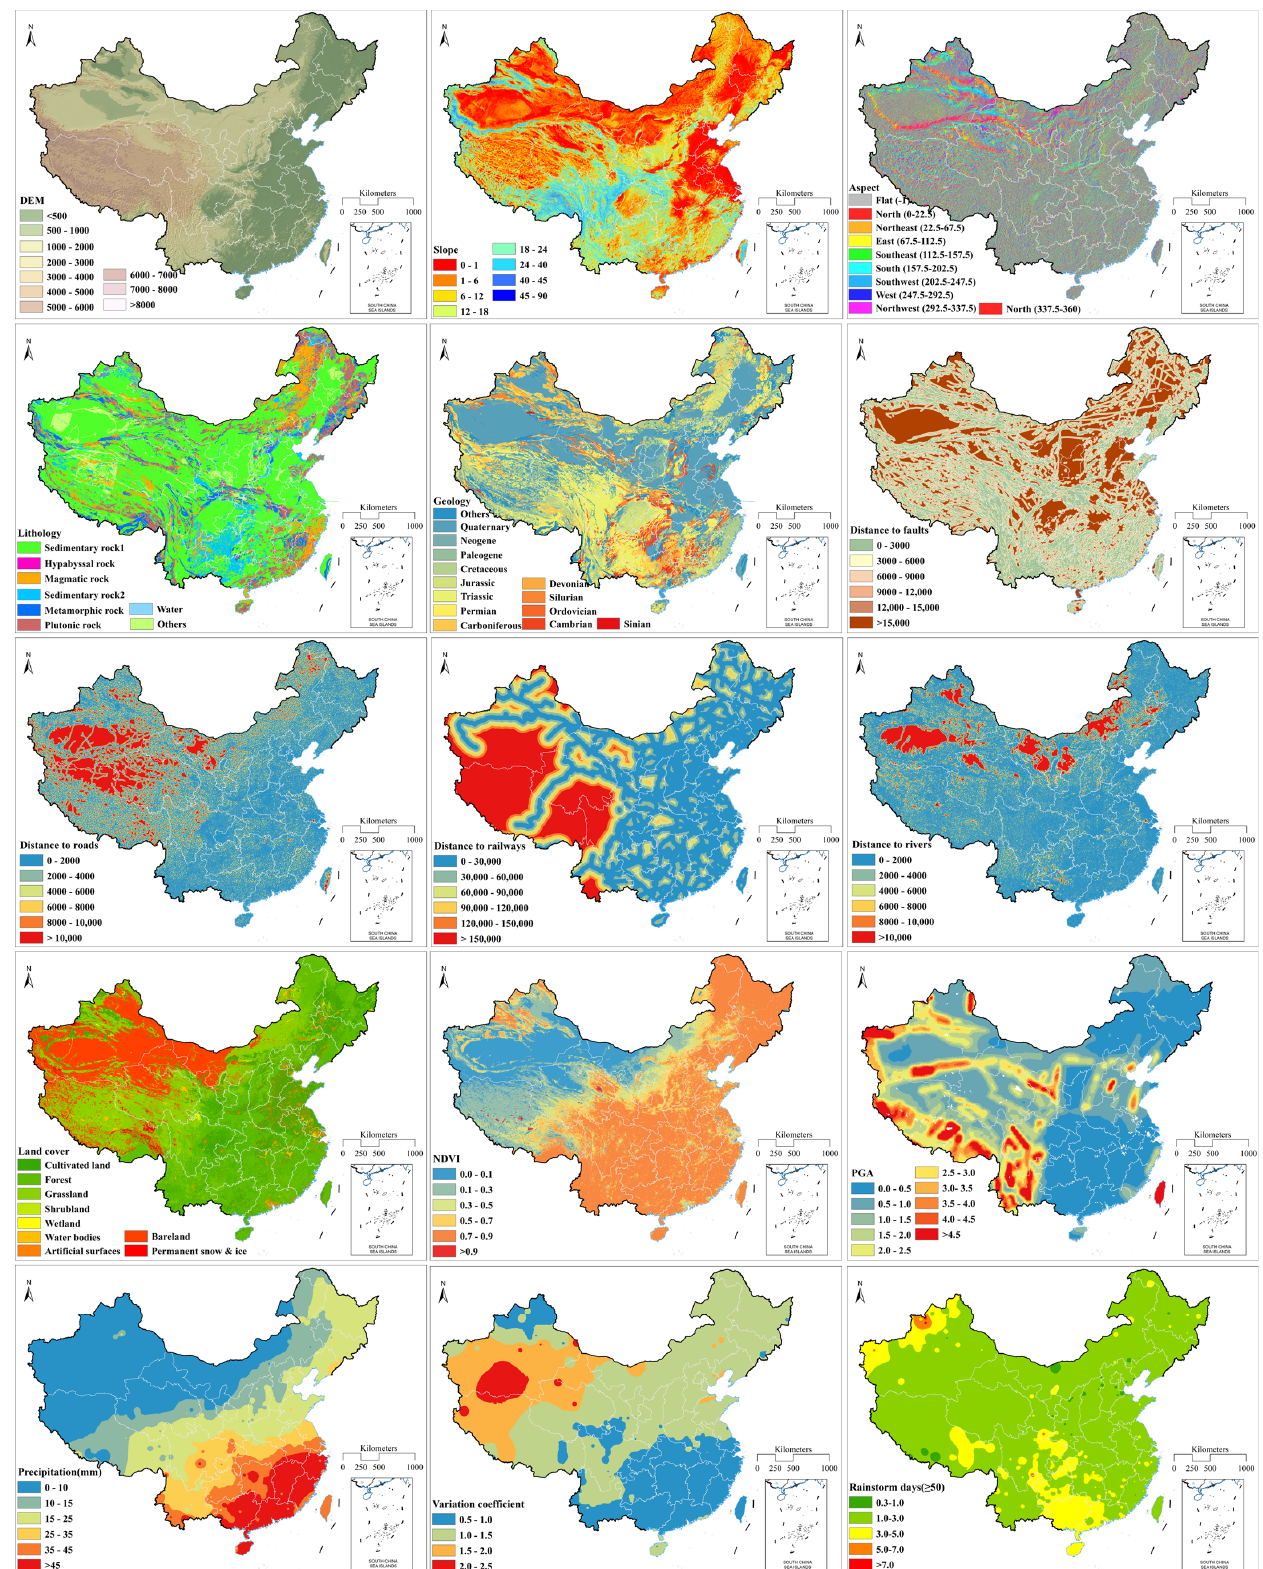
Figure 8. Characteristics of Influence Factors.